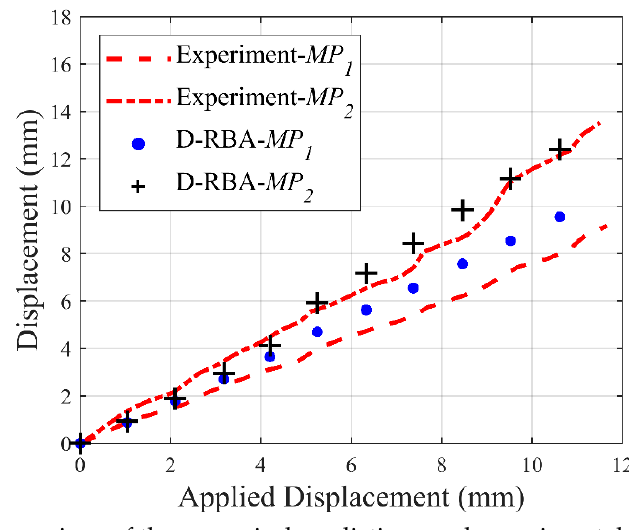
( b ) Approximated settlement profile using discrete rigid blocks. Figure 3. Representation of proposed discrete element model and applied for support settlement.